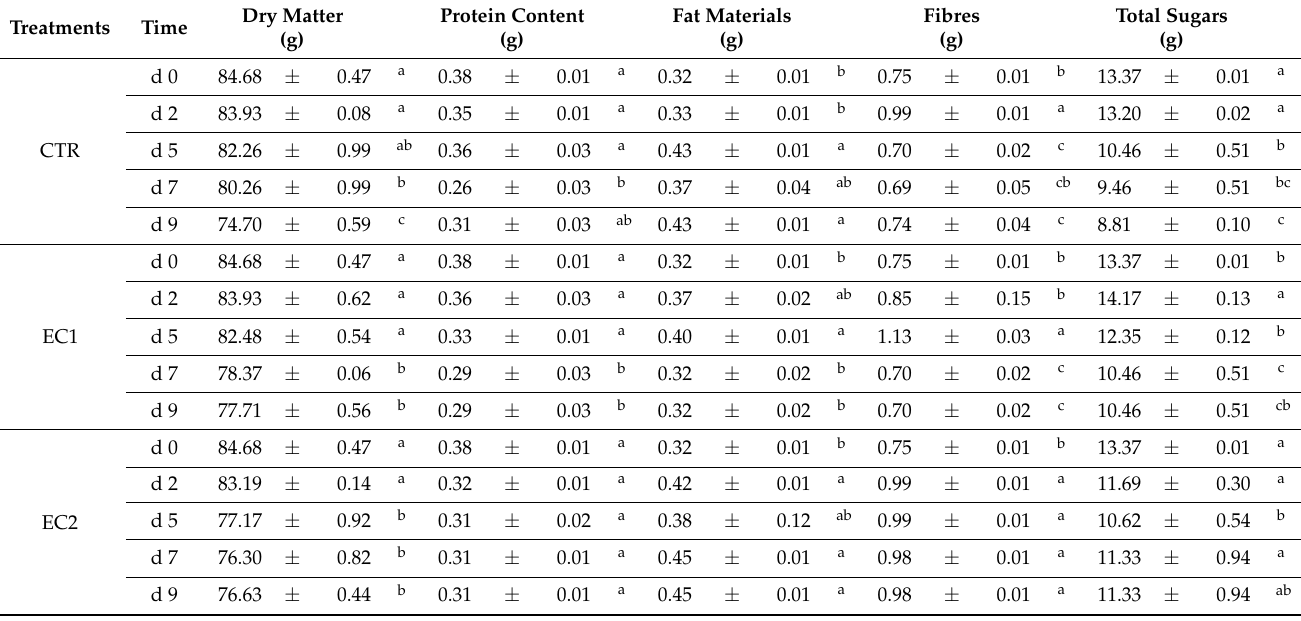
Table 2. Grams of proximate compounds in mango cube